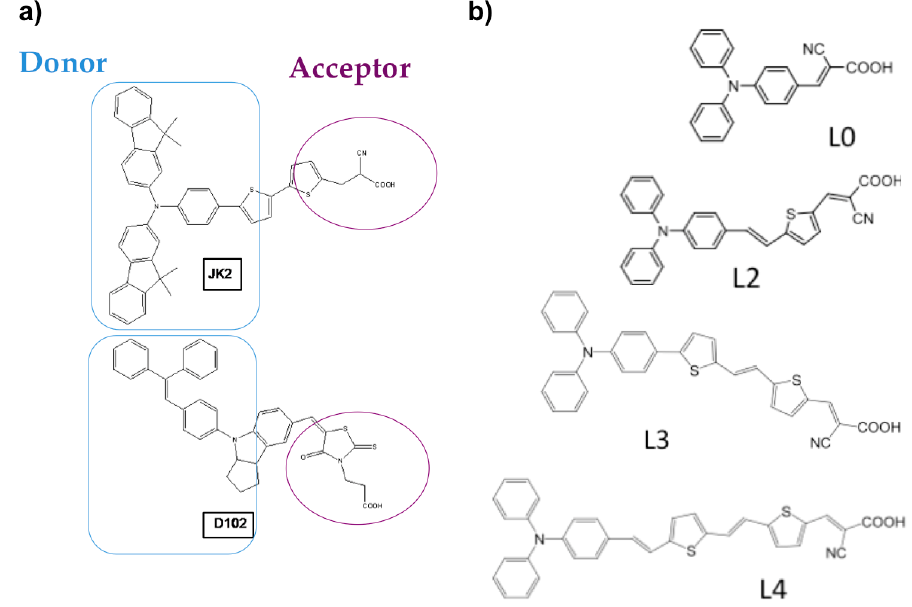
Figure 3. Molecular structure of JK2 and D102 ( a ); and of L0, L2, L3, and L4 ( b ). Table 1. TDDFT excitation energies (in eV) of the lowest excited state of JK2 and D102 in gas phase and EtOH solution for the protonated (1H) and deprotonated (0H) form compared to the experimental absorption maxima. Data from